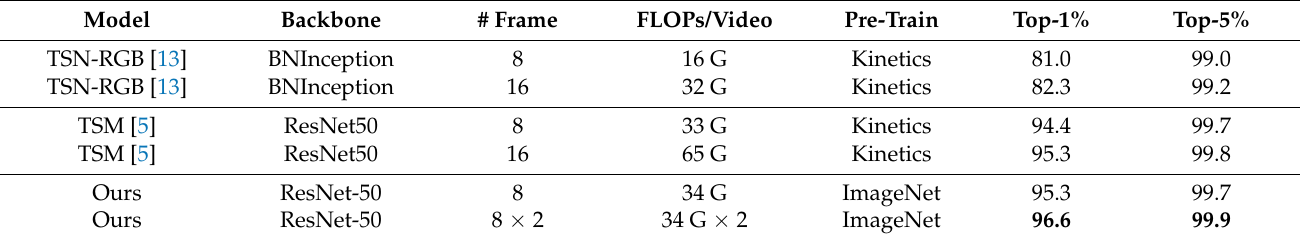
Table 5. Comparison of performances on Jester.